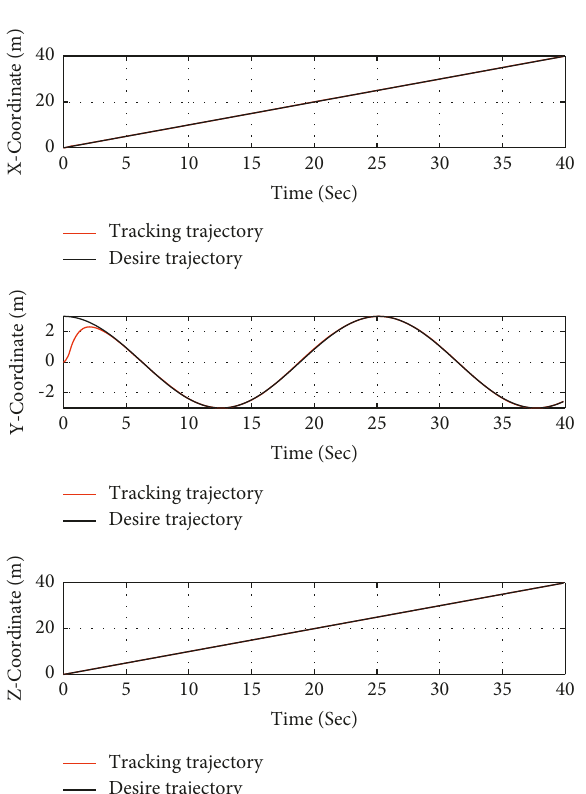
Figure 15: The trajectory tracking curve in each direction.